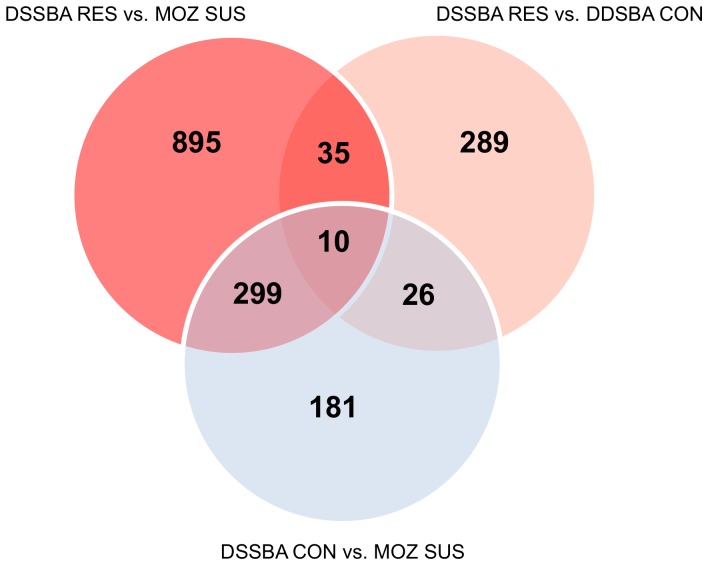
Venn diagram showing the pattern of differential expression among the microarray comparisons.Microarray probes were considered significantly expressed at p<0.05 after the application of a multiple testing correction (Benjamini-Hochberg).